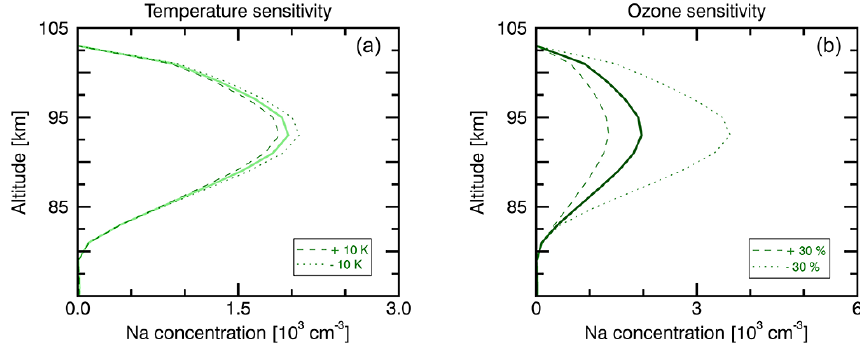
Figure 11. Sensitivity of the sodium profile to temperature changes by ± 10K (a) and ozone changes by ± 30% (b)